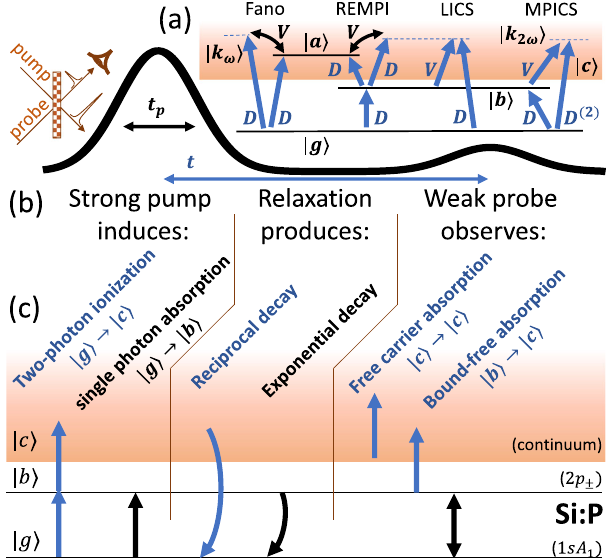
Fig. 1 Fano and related processes. a Here, g j i is the ground state, c j i (the orange band) is the one-electron continuum, and a j i is an auto-ionizing state, i.e., it is discrete and localized, but it has enough total energy that one (cid:1) (cid:3) (cid:1) electron can be kicked out of the atom into c j i . k ω (dashed blue line) is the state within the continuum that is resonant with excitation from g j i by dipole allowed transitions with perturbation Hamiltonian D at frequency (cid:1) (cid:3) (cid:1) ω , indicated here such that k is above the level of a j i , i.e., positive ω detuning, Δ . V is an energy-conserving perturbation (such as a con fi guration interaction) that couples a j i with c j i , and creates a second (cid:1) (cid:3) (cid:1) pathway from g j i ! k ω via a j i and the pathways interfere. As the detuning Δ is tuned across the resonance with a j i , the interference between the pathways changes sign. Resonance-Enhanced Multi-Photon Ionization (RE-MPI) is similar to the Fano process, involving an intermediate state. In Laser-Induced Continuum Structure (LICS), V is a (cid:1) (cid:3) (cid:1) dipole transition from a bound state b j i and now g j i ! k ω interferes with